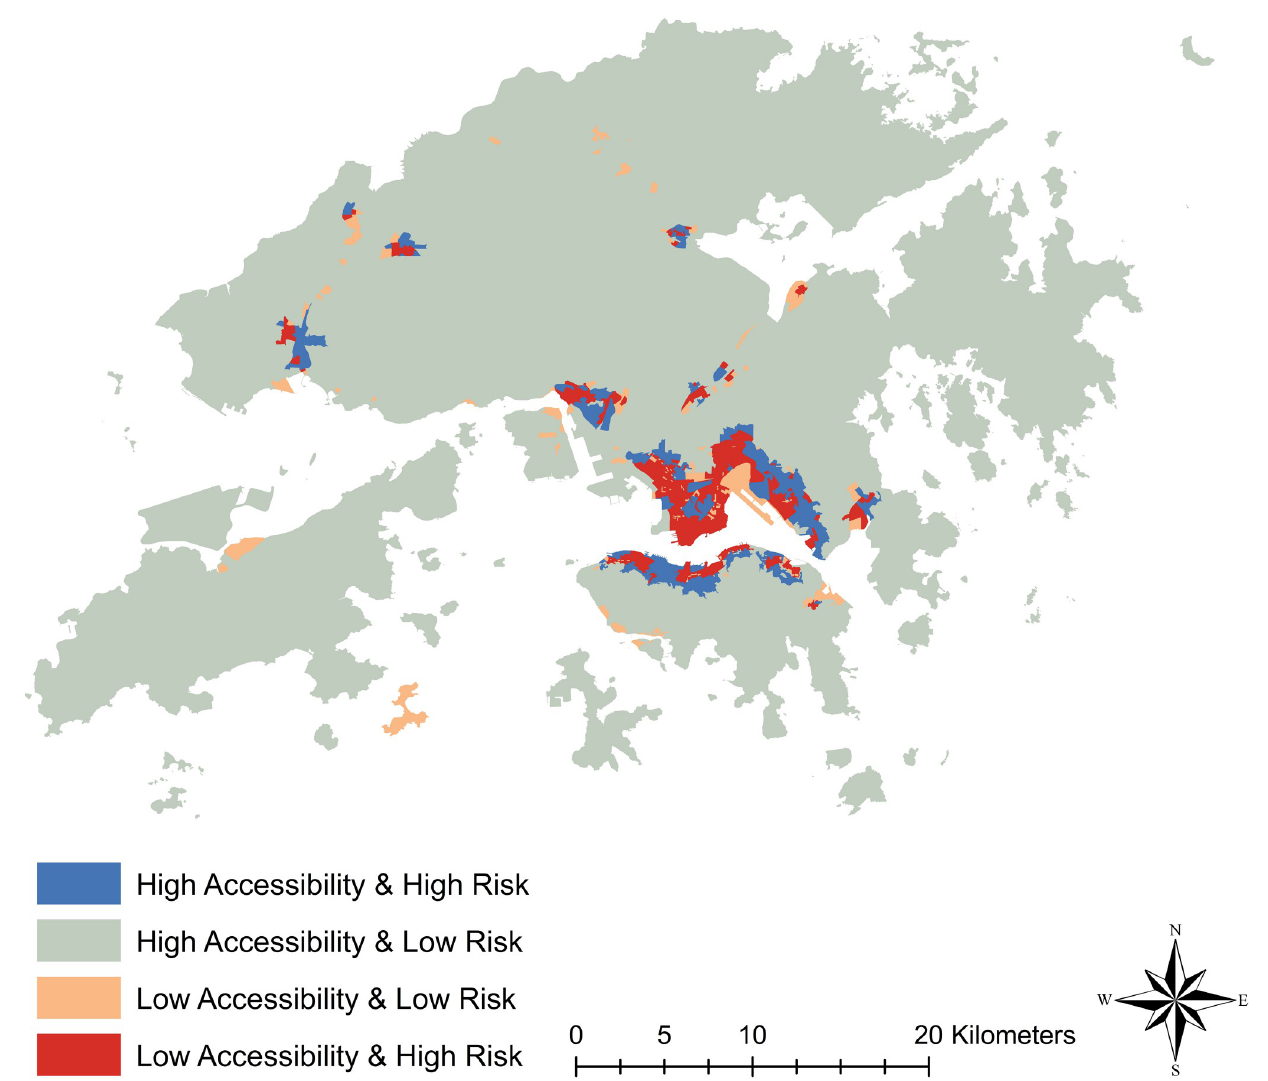
Fig 4. Comparison of green and blue spaces accessibility against COVID-19 infection